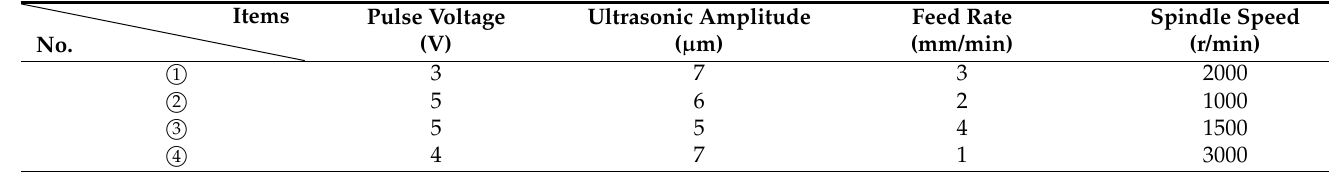
Table 5. Prediction parameters model machining parameters.